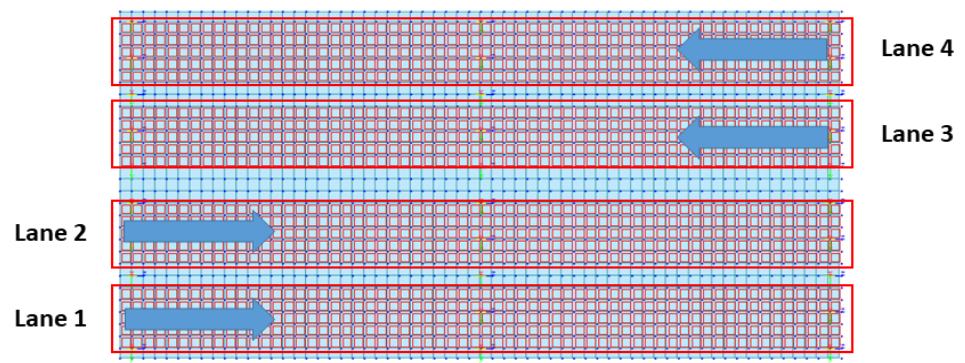
Figure 10. Directions of moving vehicles according to four lanes for RC-slab-bridge modeling (Four lanes indicate the locations for the moving point load (refer to Figure 11) used to simulate the RC-slab-bridge) .